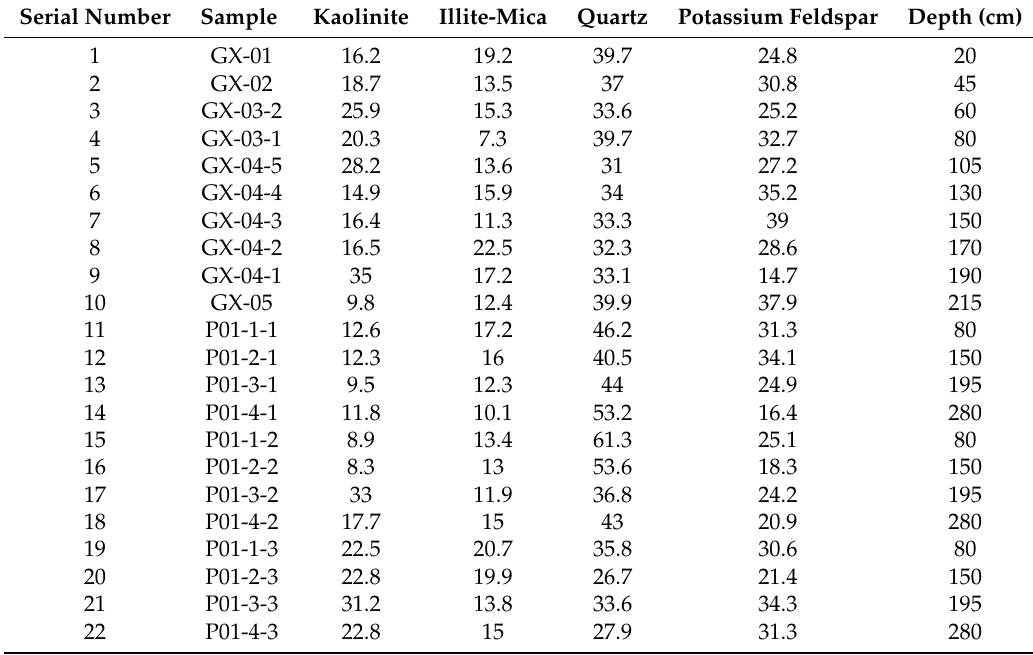
Table 3. Main clay minerals content of soil profile